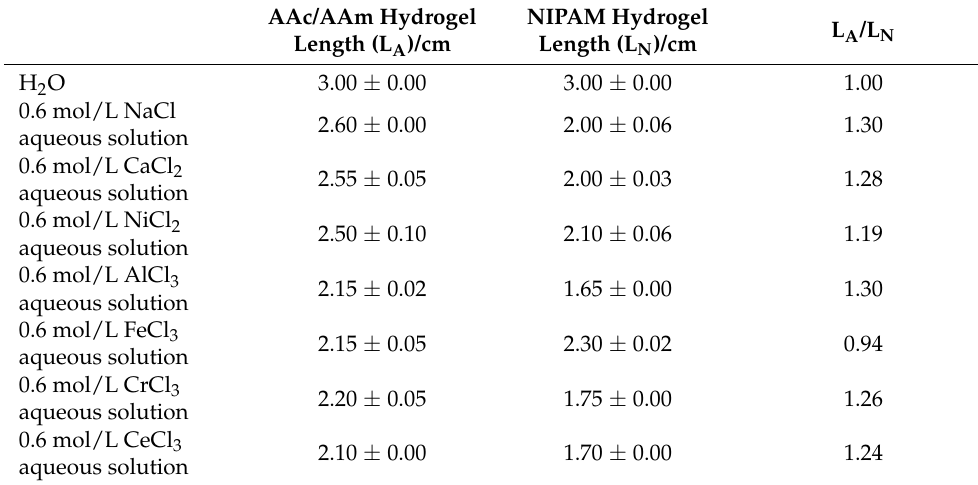
Figure 5. ( a1 – a8 ) AAc/AAm and ( b1 – b8 ) NIPAM hydrogels in 0.6 mol/L NaCl, 0.6 mol/L CaCl 2 , 0.6 mol/L NiCl 2 , 0.6 mol/L AlCl 3 , 0.6 mol/L FeCl 3 , 0.6 mol/L CrCl 3 , and 0.6 mol/L CeCl 3 solutions after 12 h. Table 1. Shrinkage ratio of the AAm/AAc layer hydrogel to the NIPAM layer hydrogel in different metal ion aqueous solutions, presented as the mean ± SD (n = 3).